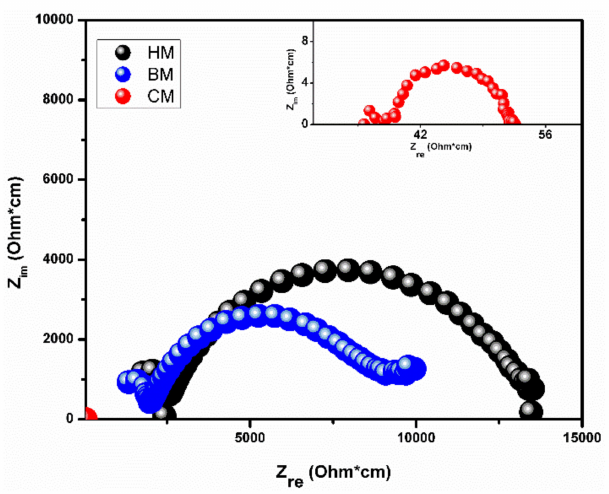
Figure 8. Impedance spectra at 350 ◦ C for the sintered samples processed through CM (red), BM (blue), and HM (black) methods.